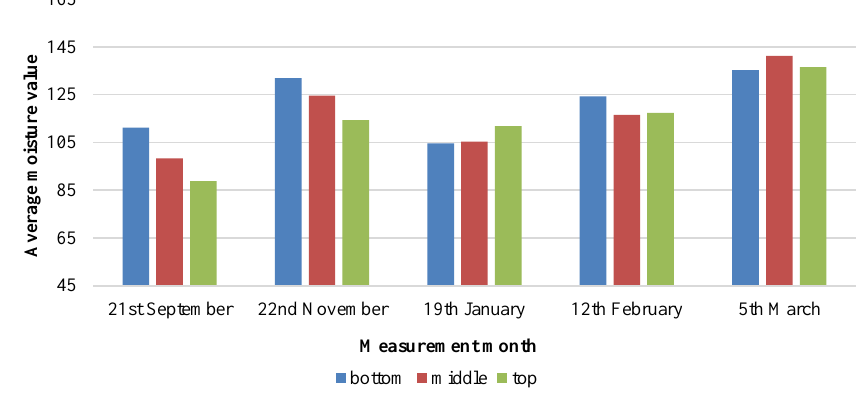
Fig. 6. Average moisture value changes for 2 cm depth